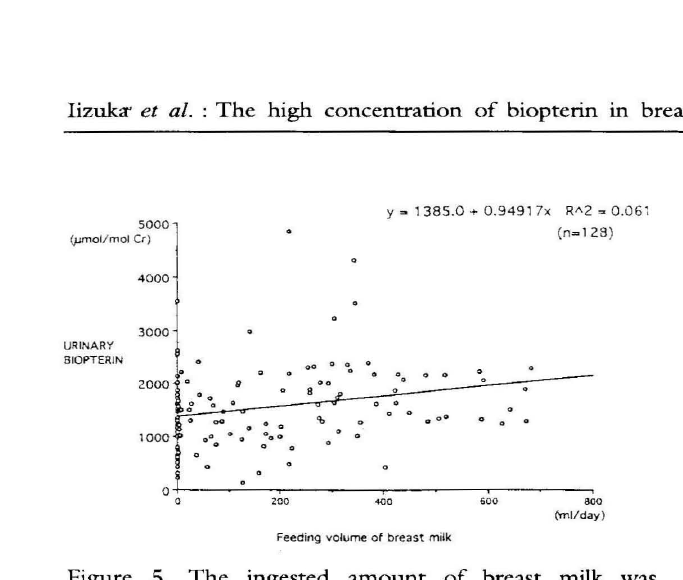
Figure 5. The ingested amount of breast milk was measured by the difference between body weight before and after feeding during the day prior to the collection of urine samples. The urinary biopterin levels had no re lationship to the volume of breas~ milk ingested.